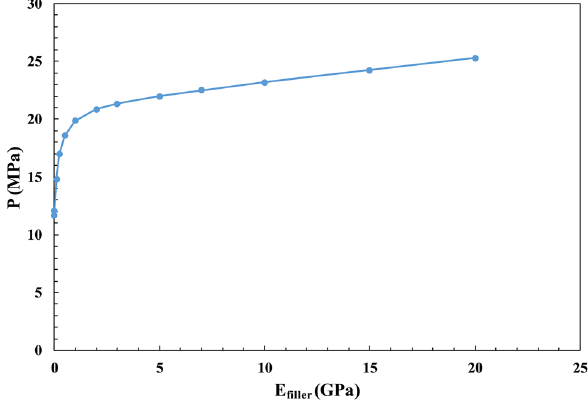
Fig. 17 Effect of composite’s longitudinal modulus relative to neglect it